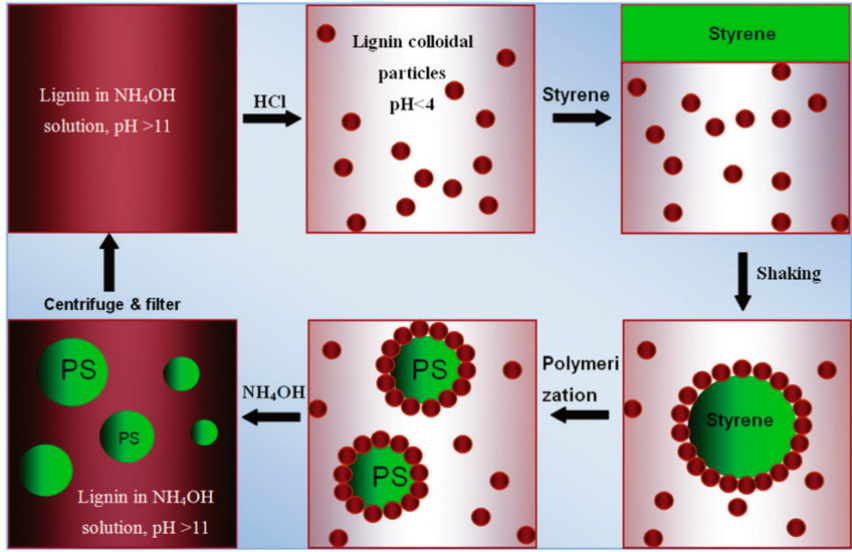
Figure 6. A schematic representation of the preparation of lignin-coated microparticles and bare polystyrene (PS) microparticles based on a lignin-stabilized Pickering emulsion including recirculation of lignin. Reproduced from [83] with permission of The Royal Society of Chemistry. Table 3. Overview of the grafted LNPs for use in Pickering emulsions.